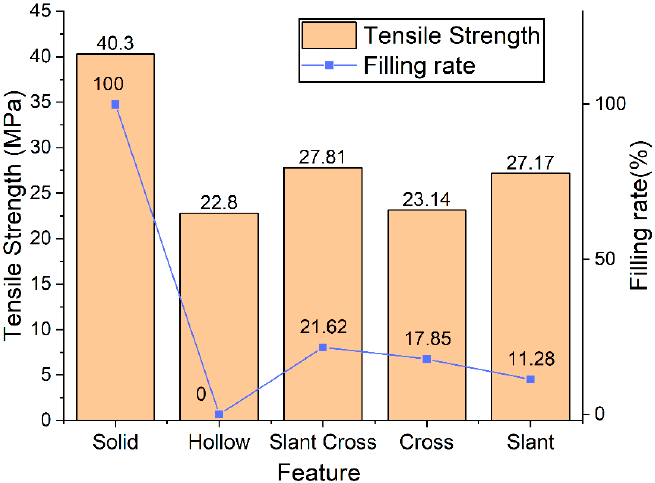
Figure 11. Tensile strength of sample components with different